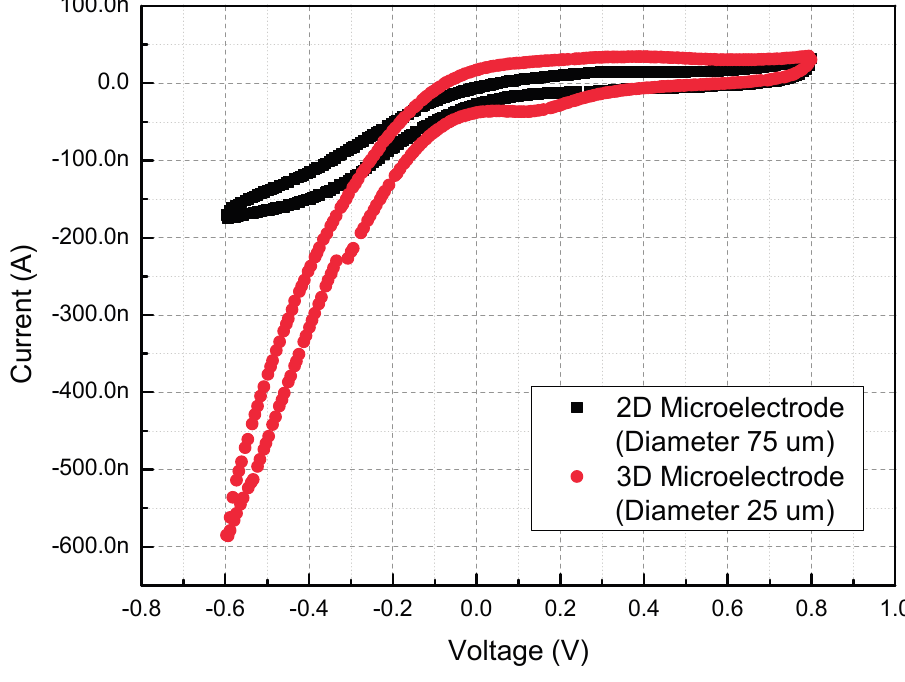
Figure 6. Cyclic voltammetry results of 2D and 3D Au